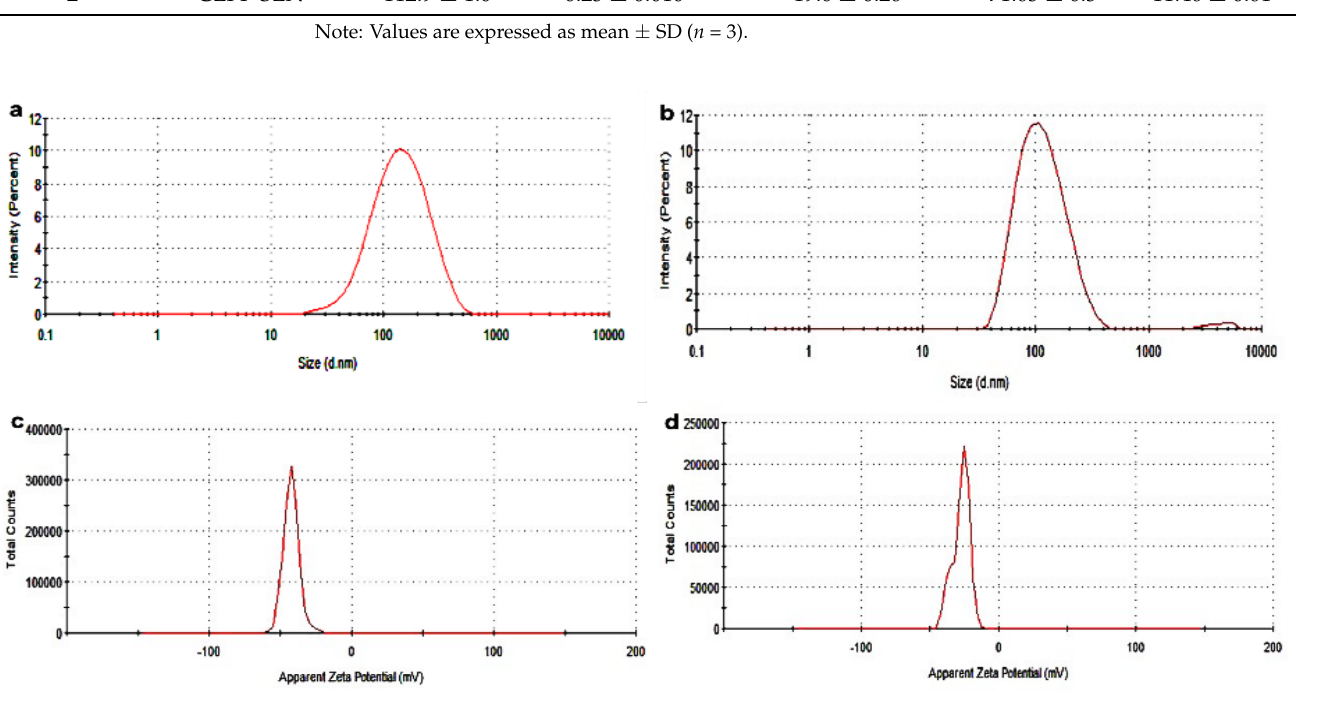
Table 1. Particle size, PDI, the zeta potential of unloaded and PZQ-loaded Compritol-lecithin solid lipid nanoparticles made with PF127, drug entrapment efficacy, and drug loading capacity.